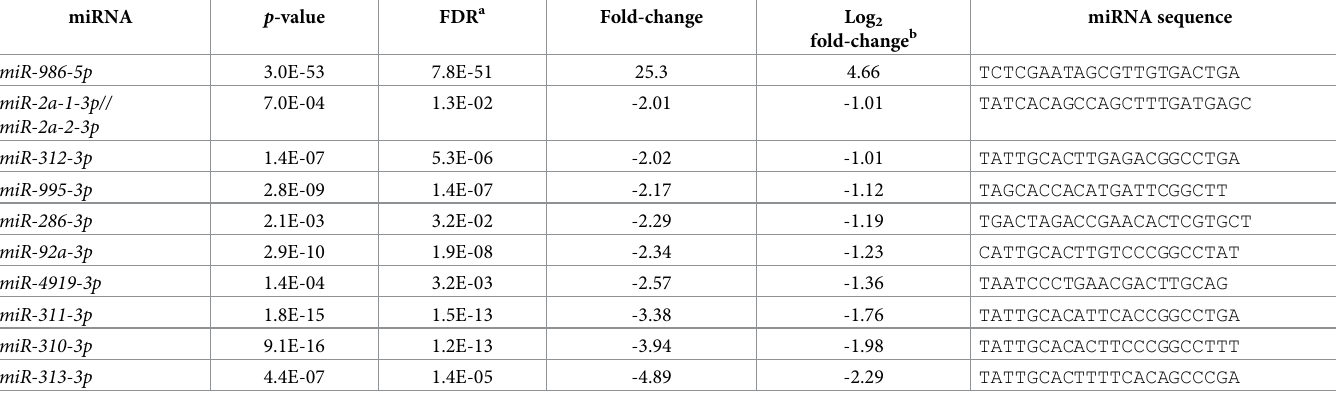
Table 3. Differentially expressed miRNAs between 91-C and 91-R .